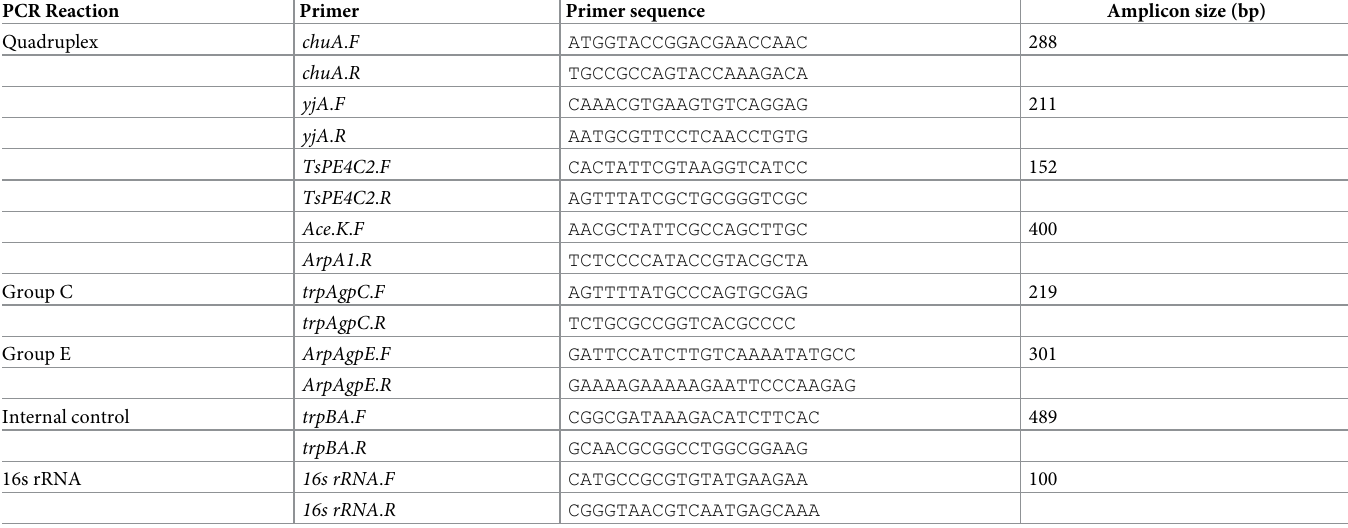
Table 1. Primer used for the phylogenotyping and E . coli identification (16s